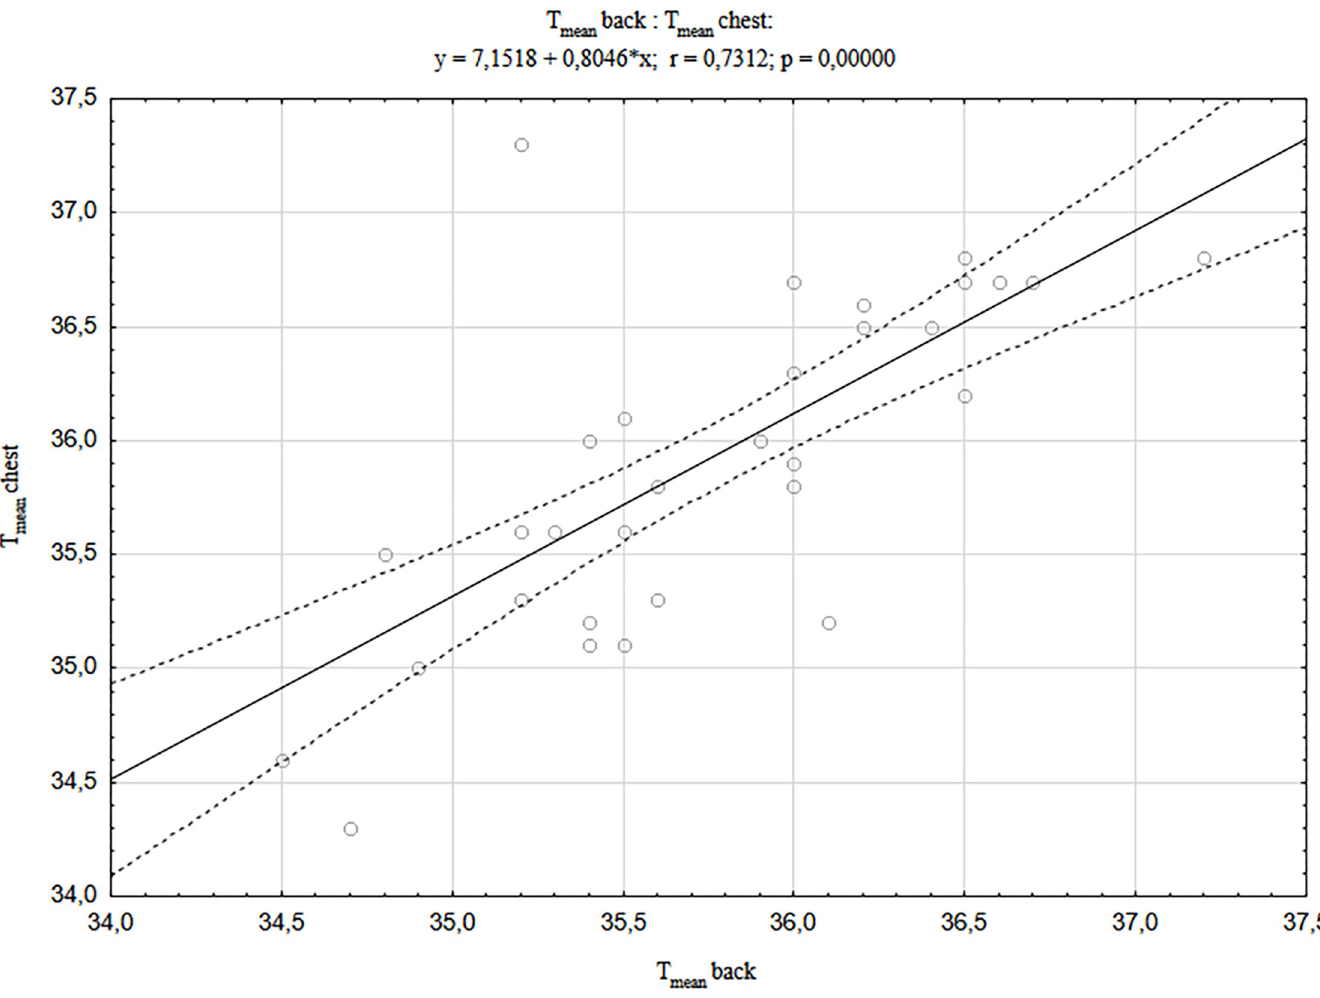
Fig 3. A correlation between T mean back and T mean chest in newborns born by CS.